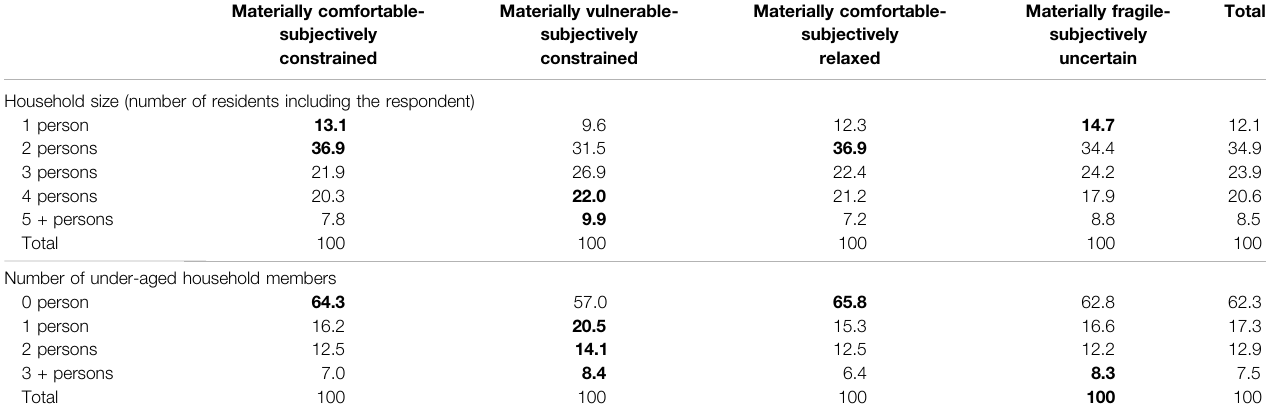
TABLE 5 | Pro fi les of social impact by household size and number of under-aged household members during lockdown (in %).